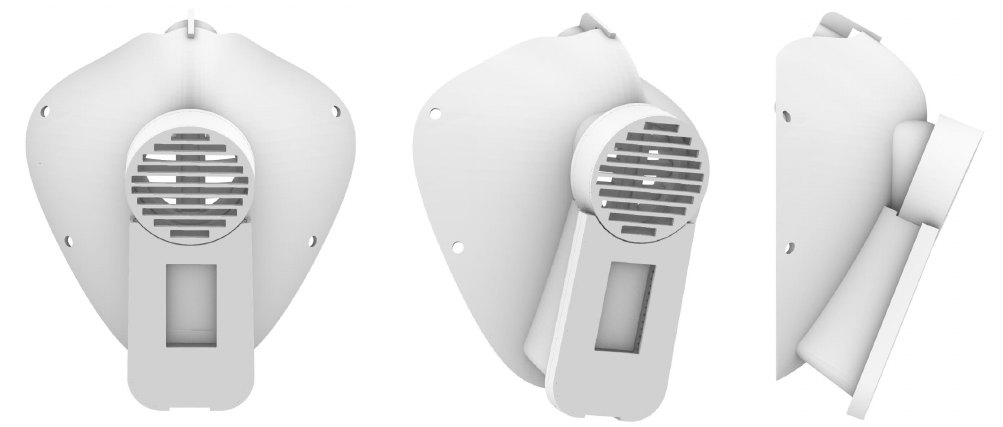
Figure 1. Design images of the assembly of the (ME) 2 3D-printed innovative